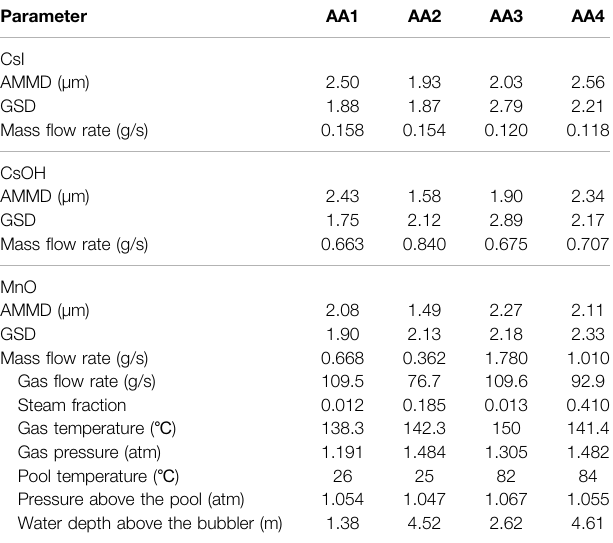
TABLE 3 | DF comparisons between calculation results and experimental data of ACE test conditions.